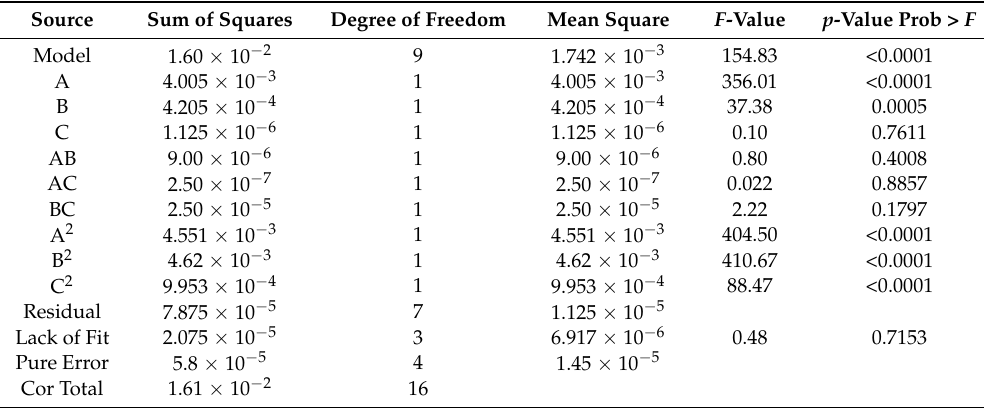
Table 2. Analysis of variance (ANOVA) for the quadratic response surface